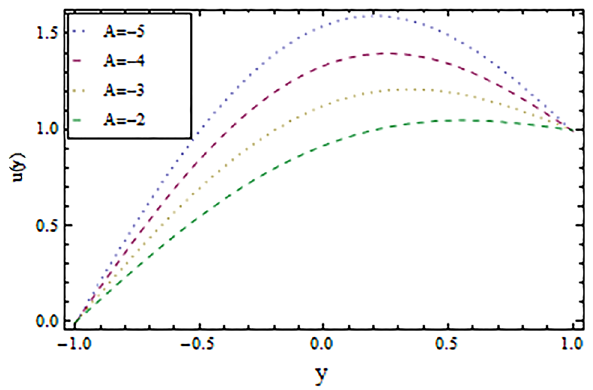
Figure 3. Velocity profile for M = 0.0002, B = 0.3and (cid:31) = 3 using NIM.